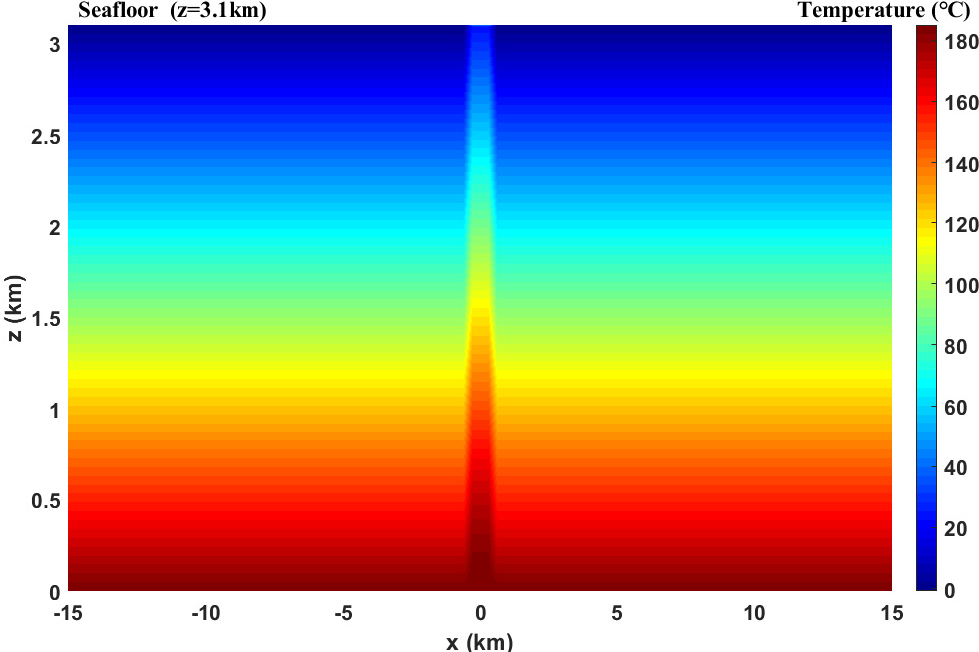
Figure 5. Based on the physical parameters of the mud volcano strata, we simulated the heat consumption and temperature variation characteristics of the mud volcano fluid migration channel after an eruption. The seafloor is set to z = 3.1